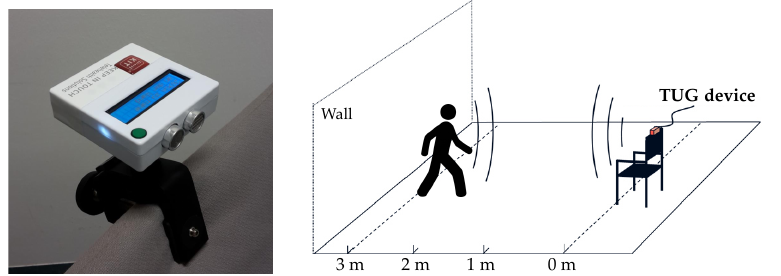
Figure 1. The TUG device is attached to the backrest of a chair ( left ). The measurement setting allowed ultrasonic-based distance measurement. The chair with the attached device was positioned 3.5 m away from a wall. Participants eventually walked 3 m ( right